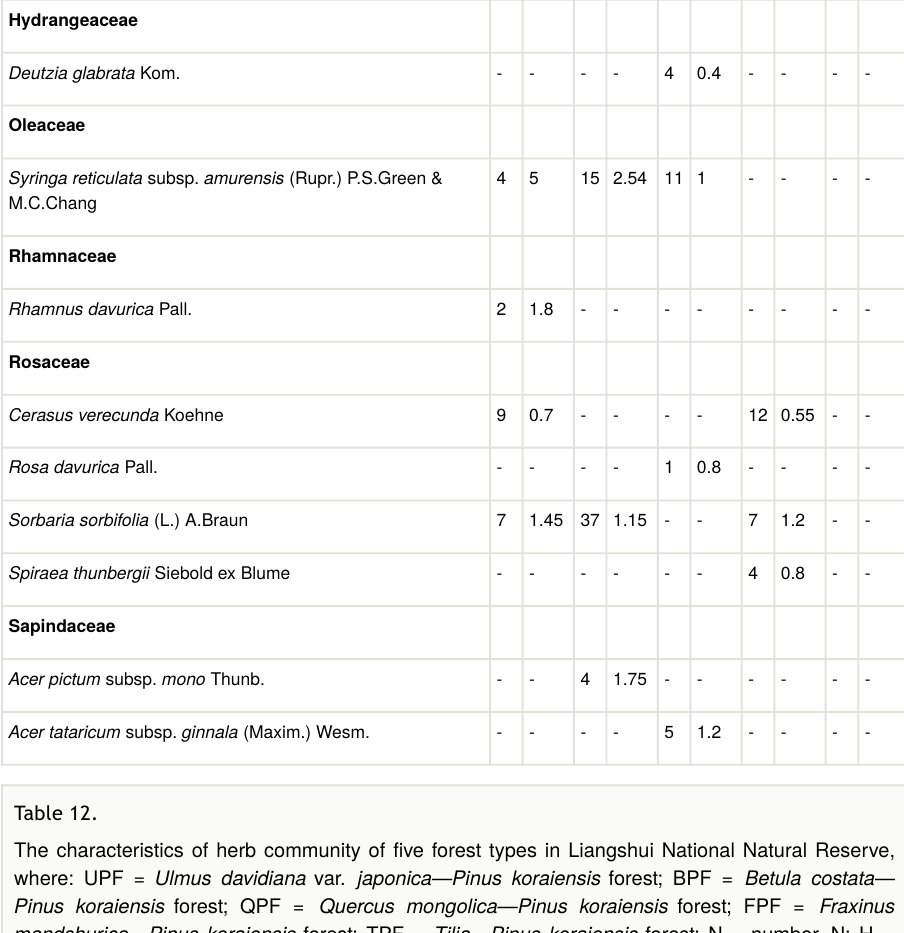
Syringa reticulata subsp. amurensis (Rupr.) P.S.Green & M.C.Chang